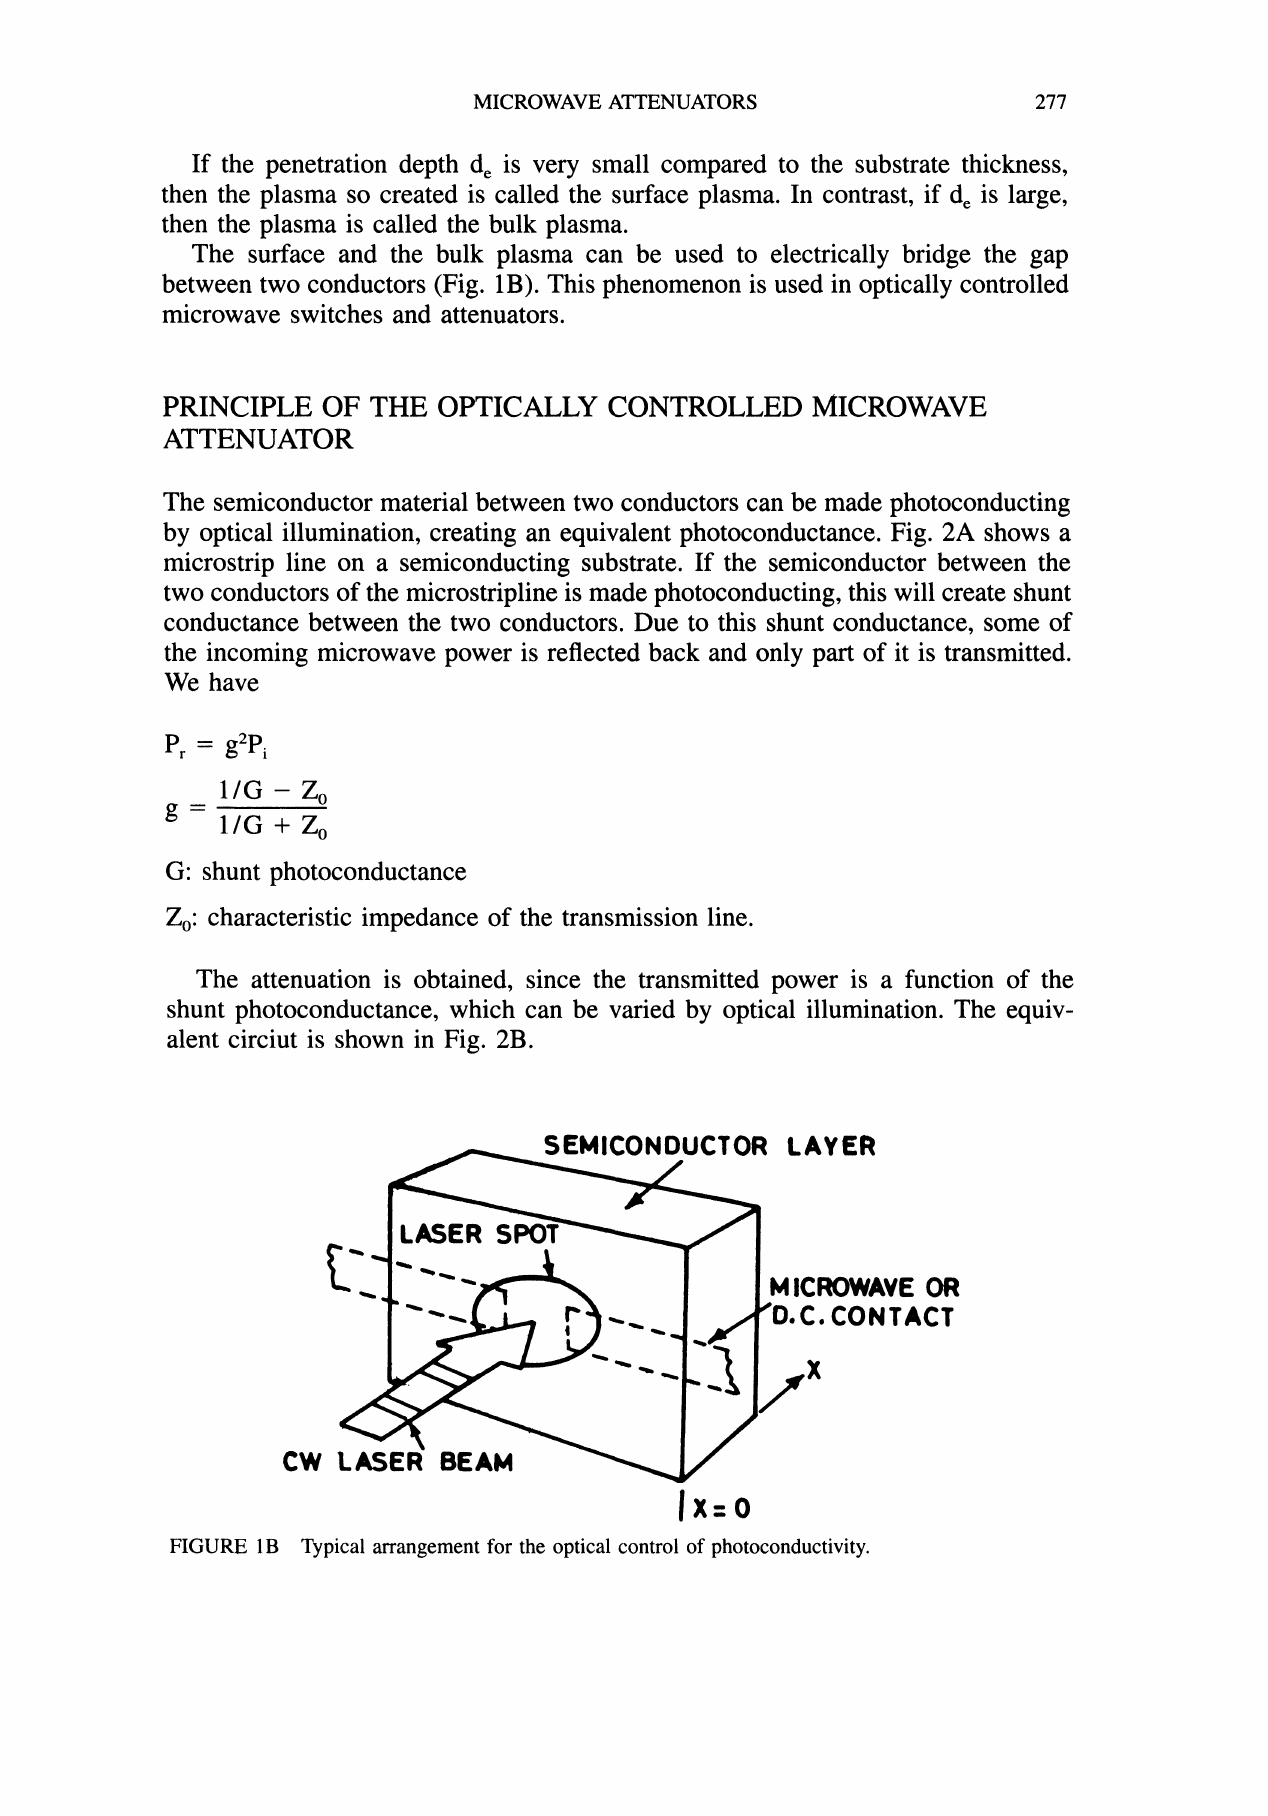
CW LASER BEAM FIGURE 1B Typical arrangement for the optical control of